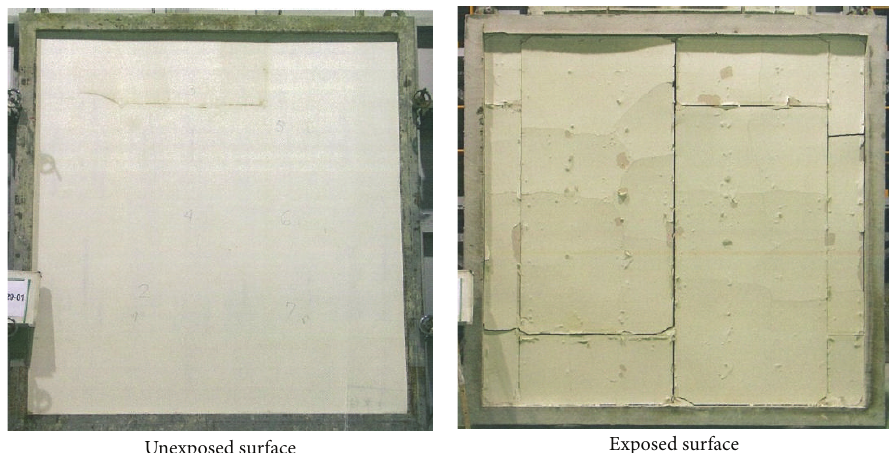
Figure 12: The result of the specimen after 60 min standard fire test in Test 1.